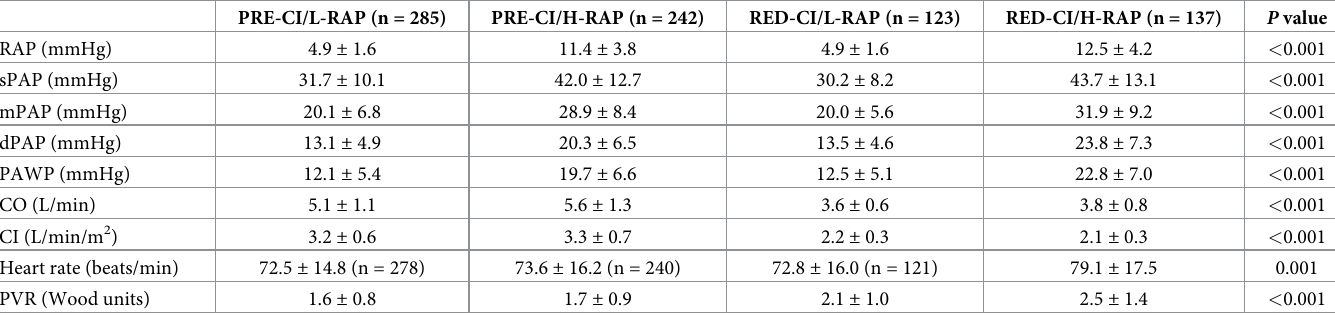
monary vascular resistance were significantly different among the 4 groups. The levels of PAWP were higher in the RAP � 8 mmHg groups than in the RAP < 8 mmHg groups. We additionally compared the parameters of echocardiography and RHC among reduced LVEF, mid-range LVEF, and preserved LVEF groups (Table 3). Left ventricular diastolic and systolic dimensions were significantly different among the three groups ( p < 0.001), with the largest in the reduced LVEF group, followed by the mid-range LVEF group, and the smallest in the preserved LVEF group. Tricuspid annular plane systolic excursion and CI showed statis- tically significant differences among the three groups ( p < 0.001), with the highest in the pre- served LVEF group, followed by the mid-range group, and the lowest in the reduced LVEF group. Overall, the mid-range LVEF group was intermediate between the reduced and pre- served LVEF groups regarding morphological findings and function. There were no significant differences in the values of mPAP ( p = 0.09). tion occurred in 60, 153, and 6 patients, respectively. As a result, the primary endpoints were observed in 181 patients. The Kaplan-Meier curves for the primary endpoints are shown in Fig 2A. Survival curves showed clear risk stratification in the order of hemodynamic severity. The log-rank test revealed a significant increase in adverse events in the RED-CI/L-RAP and RED-CI/H-RAP groups compared with that in the PRE-CI/L-RAP group ( p = 0.006 for PRE-CI/L-RAP vs. RED-CI/L-RAP; p < 0.001 for PRE-CI/L-RAP vs. RED-CI/H-RAP), while there was no significant difference between the PRE-CI/L-RAP and PRE-CI/H-RAP groups ( p = 0.13). The Kaplan-Meier curves for cardiac death, heart failure readmission, and LVAD Table 2. Parameters of right heart